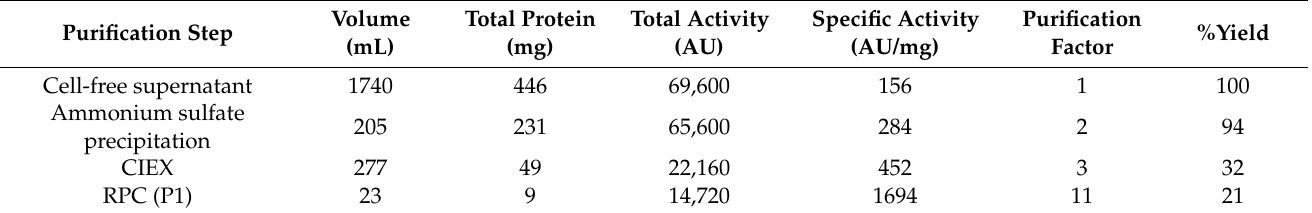
Table 1. The purification balance sheet of anti-MRSA substance (P1) from SPR-20. The antimicrobial activity was determined by an agar well diffusion test against MRSA isolate 2468.